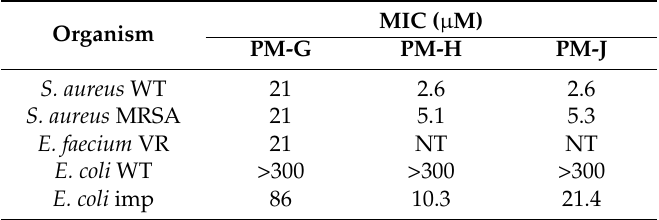
Table 3. Antibacterial activities of pyrrolomycins G, H and